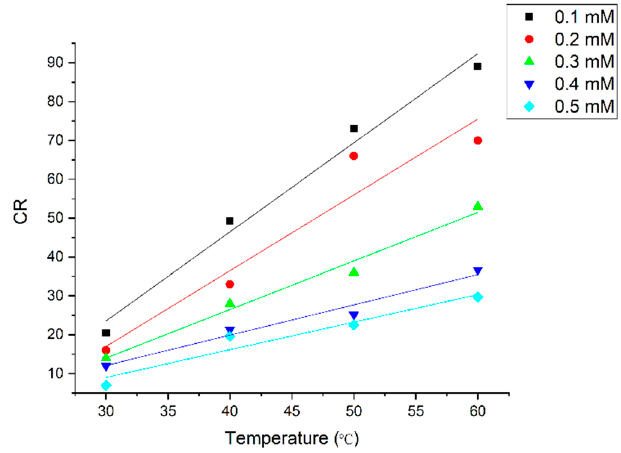
Figure 8. E ff ect of temperature on CR at di ff erent concentrations for an immersion time of 5 h. Figure 8. Effect of temperature on CR at different concentrations for an immersion time of 5 h.